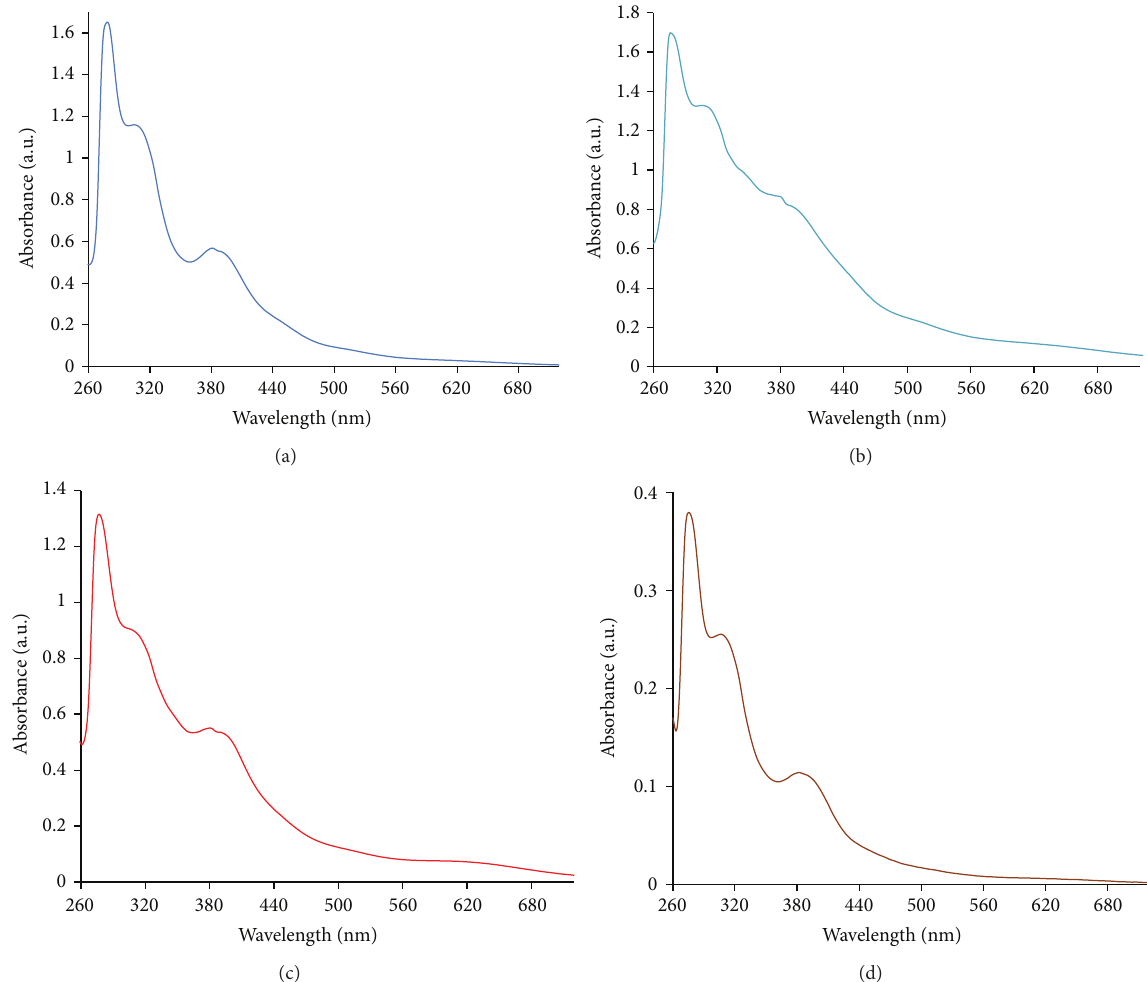
Figure 1: Electronic absorption spectra of the Ru(III) complexes: (a) [Ru(DAE)Cl 2 (H 2 O)]; (b) [Ru(HME)Cl 2 (H 2 O)]; (c) [Ru(MBE)Cl 2 (H 2 O)]; (d) [Ru(DEE)Cl 2 (H 2 O)]. energy are 2 A 2 and 2 T 1 , arising from t 4 2 g g